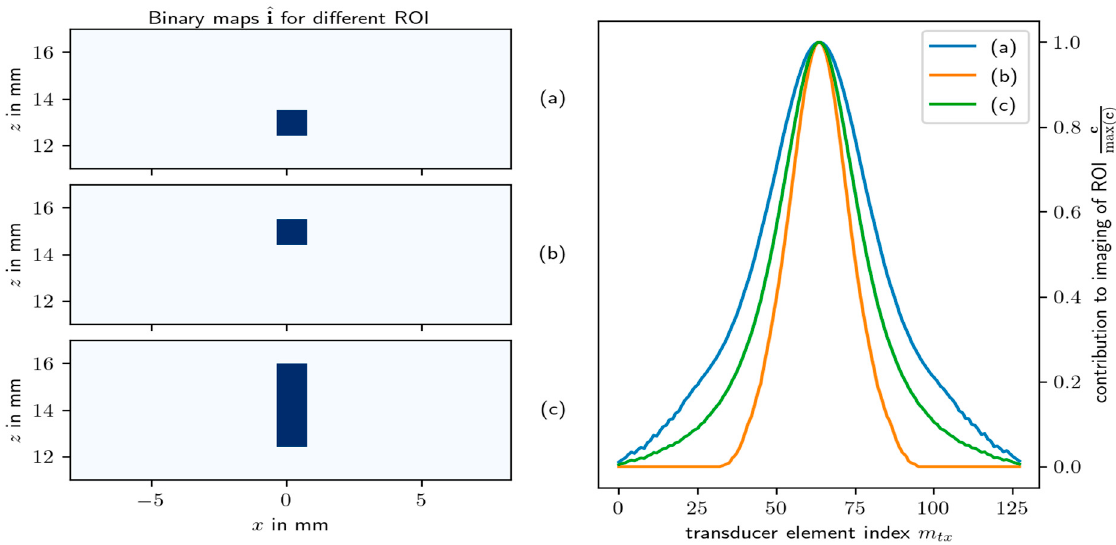
^ ı , on the visibility by each